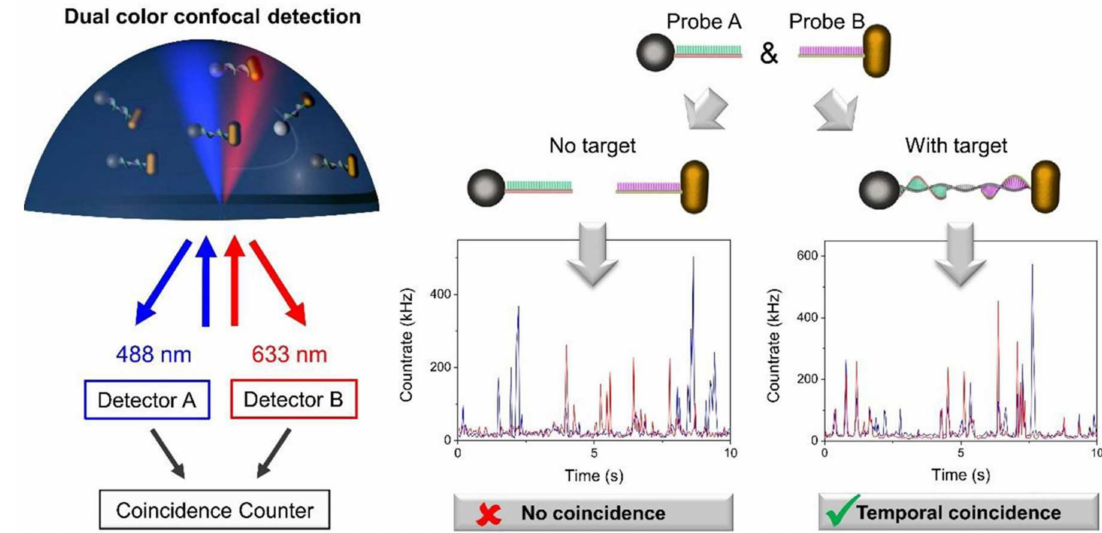
Figure 9. Principle of photon cross-correlation spectroscopy using AgNPs and AuNPs: the sample containing the probe metal NPs is illuminated by two lasers at different wavelengths (488 nm-blue and 633 nm-red). The resulting scattering signal is acquired to detect temporal coincidences between both signals. In the presence of the target DNA, nanoparticle probes A and B yielded temporal coincidence. Reprinted with permission from [123]. Copyright 2018